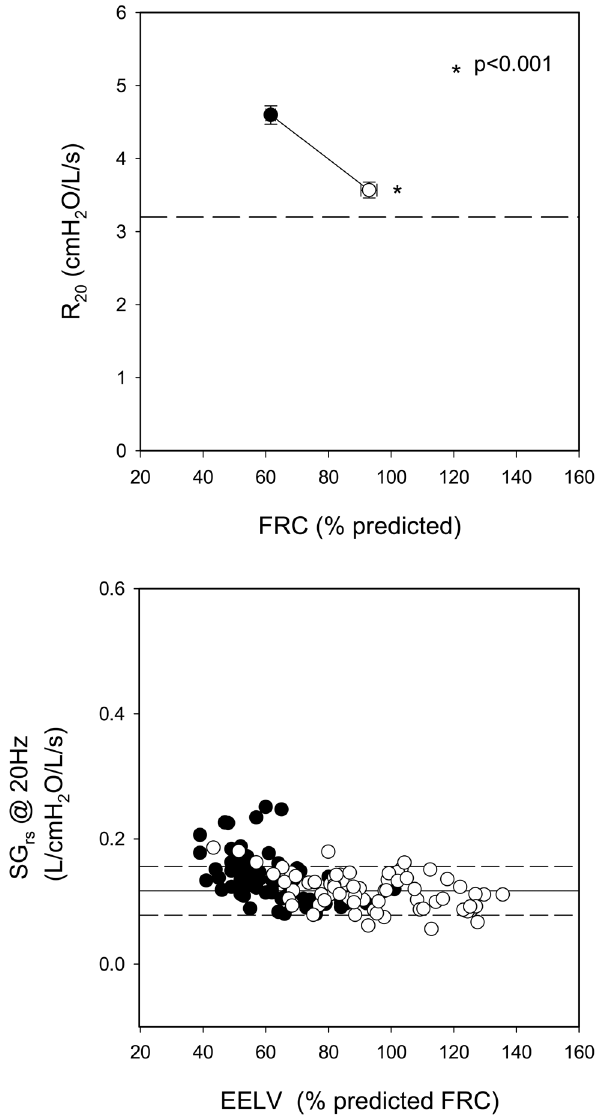
Figure 4. Top Panel: R 20 at baseline and during voluntary inflation. Data are mean 6 SE. Dotted line represents the upper limit of normal. Bottom Panel: Individual values for specific conductance at 20 Hz (SG rs @ 20 Hz) plotted as a function of the absolute EELV at which it was obtained. EELV is expressed as % predicted FRC. Dotted and solid N lines represent the mean 6 1.65 SD calculated from data obtained in =baseline # =voluntary inflation). normal subjects. ( doi:10.1371/journal.pone.0088015.g004 Figure 5. Top Panel: R